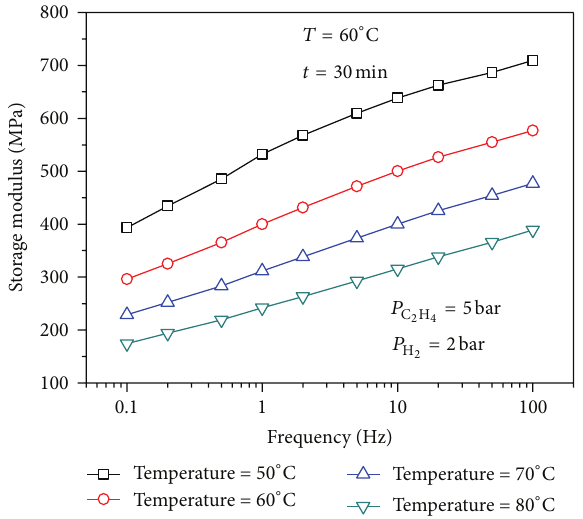
Figure 1: Dynamic temperature step/frequency sweep for polyethy- lene sample 5 synthesized at 𝑃 temperature = 60 ∘ C, and 𝑡